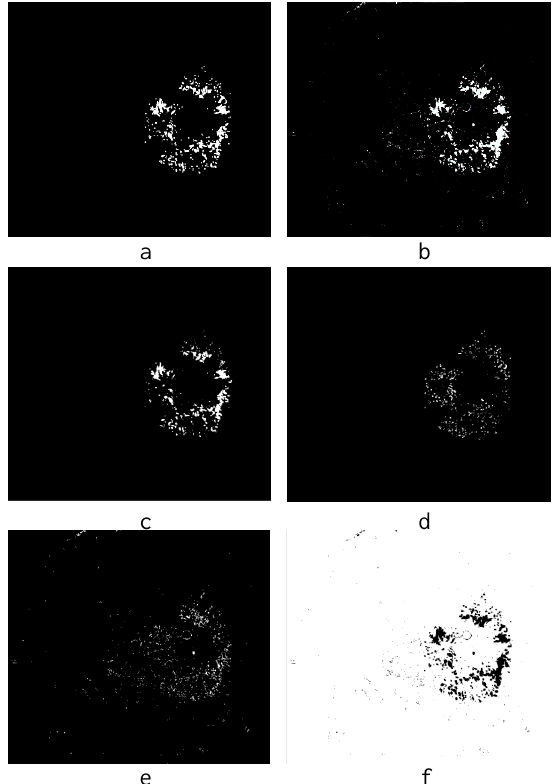
f e Figure 8. The results of different evaluation parameters for the test image of figure 7-a a) ground truth, b) result of the proposed algorithm, c) TP, d) FN, e) FP, and f) TN